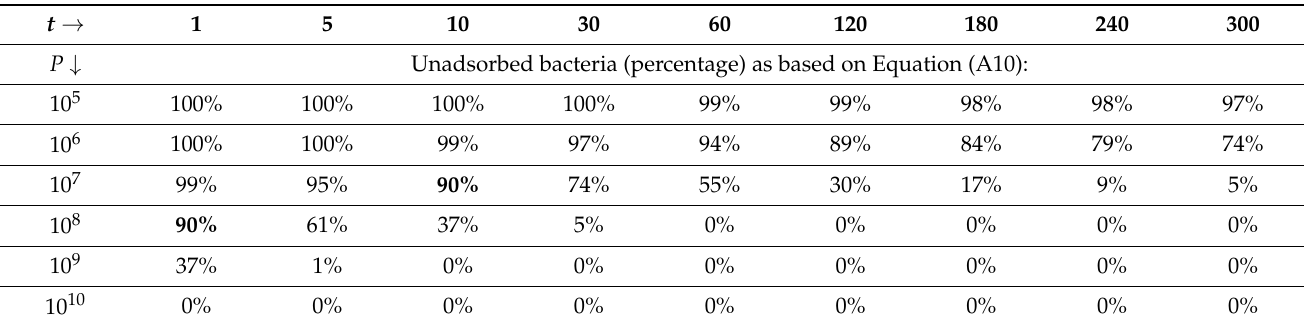
Table A2. Percentage of bacteria remaining unadsorbed as functions of phage titers ( P ) and adsorption